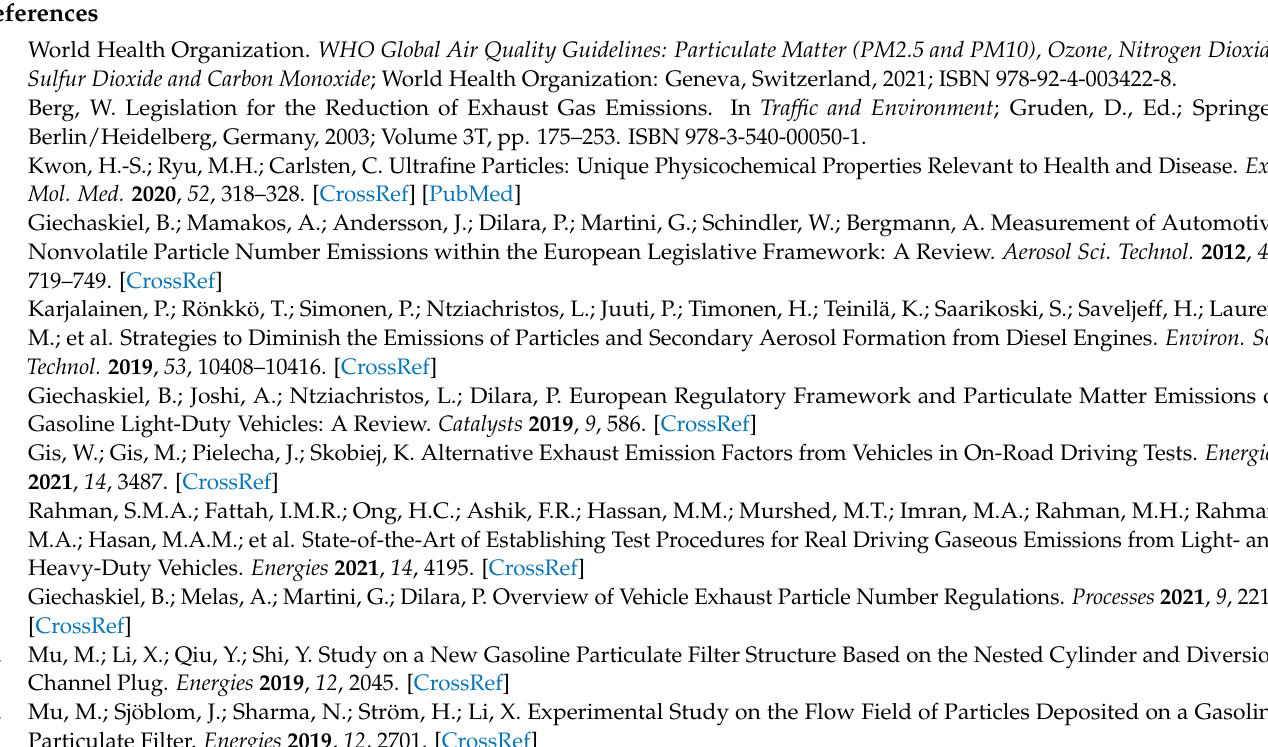
Figure A3. Accelerator pedal position and engine load for the acceleration tests at −4 °C.